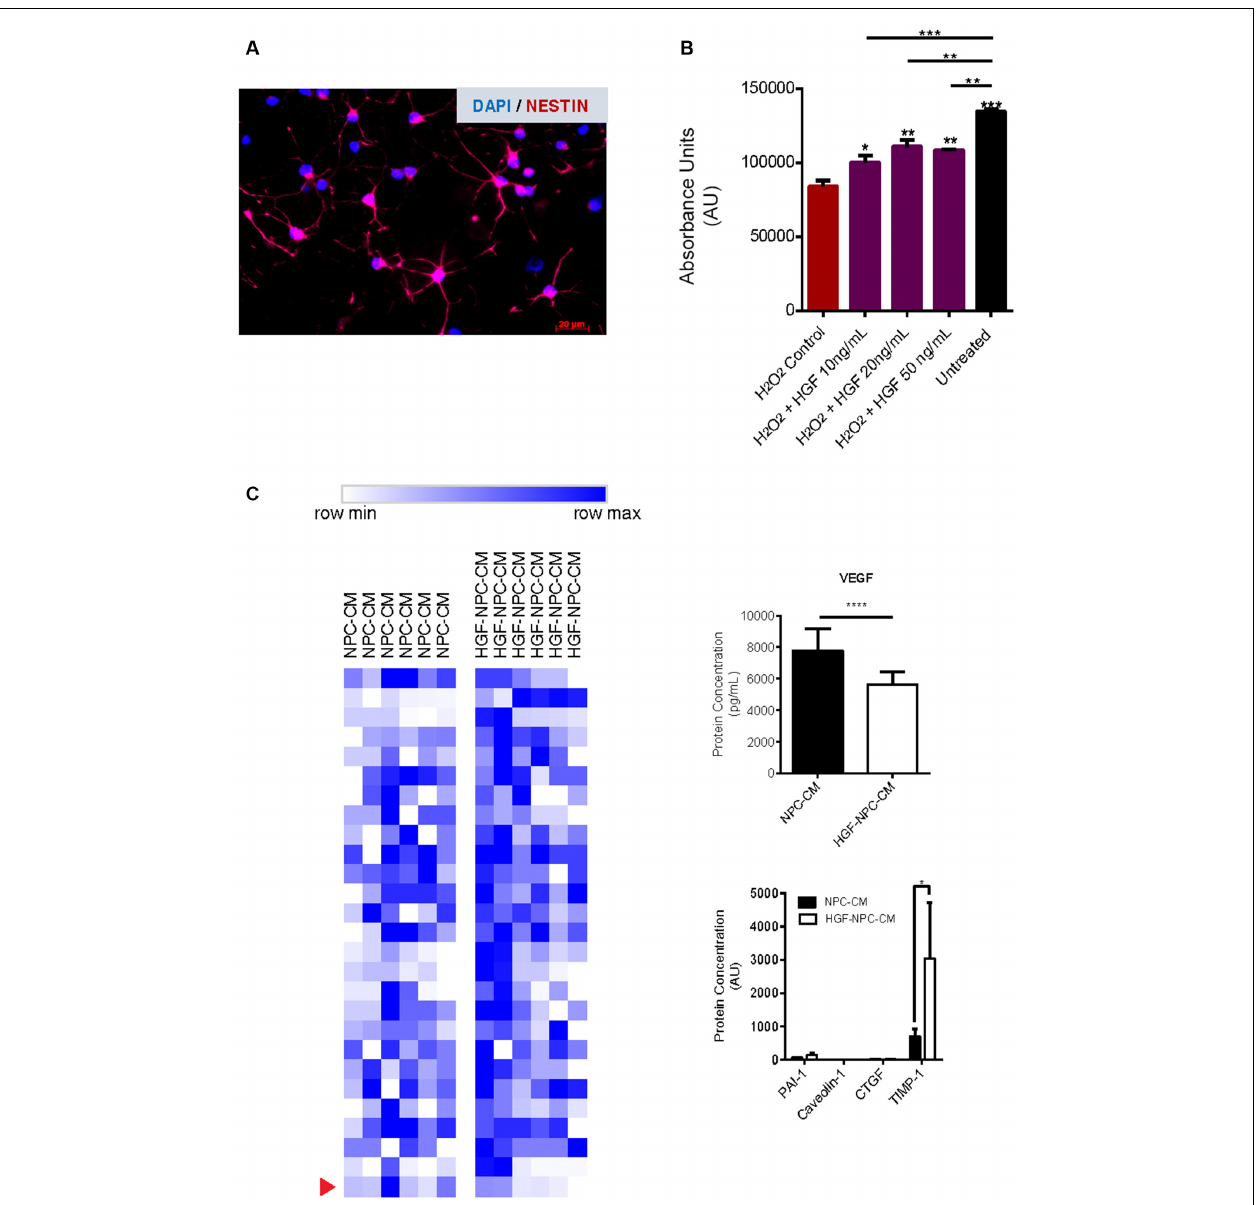
FIGURE 1 | Hepatocyte growth factor (HGF)-preconditioned NSPCs demonstrate reduced levels of VEGF and increased TIMP-1 production. (A) Characterization of rat spinal cord-derived NSPCs grown in monolayer. Immunocytochemistry revealed cellular expression of the progenitor cell marker Nestin. Representative image taken at 20 × using a Zeiss Axioplan 2 epifluorescence microscope. (B) Plated rat spinal cord-derived NSPCs were subjected to oxidative stress via hydrogen peroxide and treated for 24 h with recombinant human HGF at different concentrations. MTT reagent was applied in accordance with the manufacturer’s instructions and absorbance was measured at 570 nm. A reduction of approximately 40% was observed in the viable cell numbers of hydrogen peroxide-treated NSPCs relative to untreated cells. Concurrent administration of HGF protein to hydrogen peroxide-treated NSPCs demonstrated significantly increased cell viability relative to hydrogen peroxide-treated controls, with higher concentrations of HGF (20 ng/ml and 50 ng/ml) exhibiting the most notable effects. Data are expressed as mean ± SEM and presented as the total number of viable cells compared to hydrogen peroxide-treated NSPC controls. One-way ANOVA statistical analysis with Tukey’s post hoc test was performed; * p ≤ 0.05; ** p ≤ 0.01; *** p ≤ 0.001; **** p ≤ 0.0001. (C) NSPCs were preconditioned using HGF protein at a concentration of 20 ng/ml based on measures of cell viability upon exposure to oxidative stress, as described previously. Secretory cytokine changes in HGF-preconditioned NSPCs were assessed using the Rat Cytokine Array/Chemokine Array 27 Plex (RD27) and Rat Vascular Injury P1-4-Plex kits, comparing the relative levels of 27 and four cytokines, respectively. Protein levels were normalized to untreated NPC-CM controls ( n = 6). Heat mapping was used to depict relative protein concentrations (measured in pg/ml or AU) for each individual sample. Color gradient represents the range from row minimum to maximum. Of the proteins examined in the cytokine/chemokine and vascular arrays, VEGF and TIMP1 were the only proteins to reach significance (p-adjusted < 0.05), and their concentrations are shown as mean ±